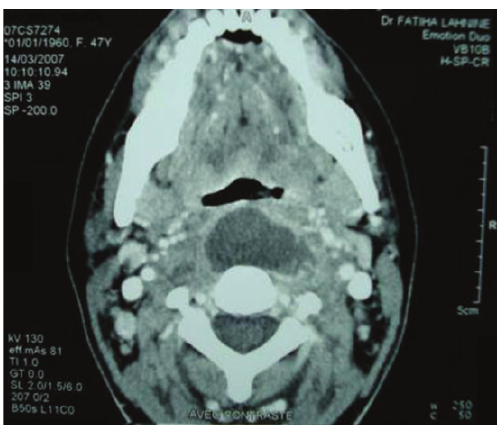
FIGURE 4: CT (transversal view) showing retropharyngeal